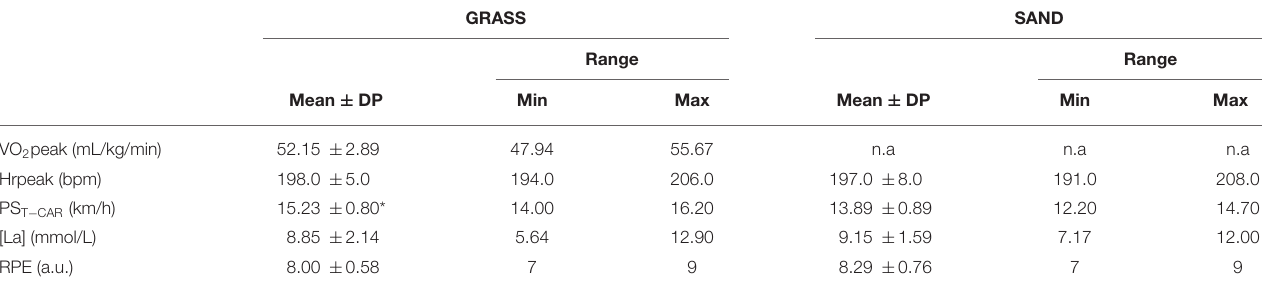
TABLE 1 | Descriptive statistics (mean ± DP; and range) for physiological, metabolic, perceptual, and peak speed reached during the Carminatti’s test performed on GRASS and SAND training surfaces. GRASS SAND Range